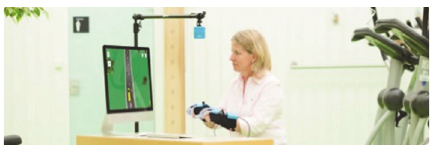
Figure 1: YouGrabber (cid:2) setup. A model is displayed during virtual reality-based training on the YouGrabber system. The screen shows agametodirectacaronacurvystreetwithmovementofbothupper